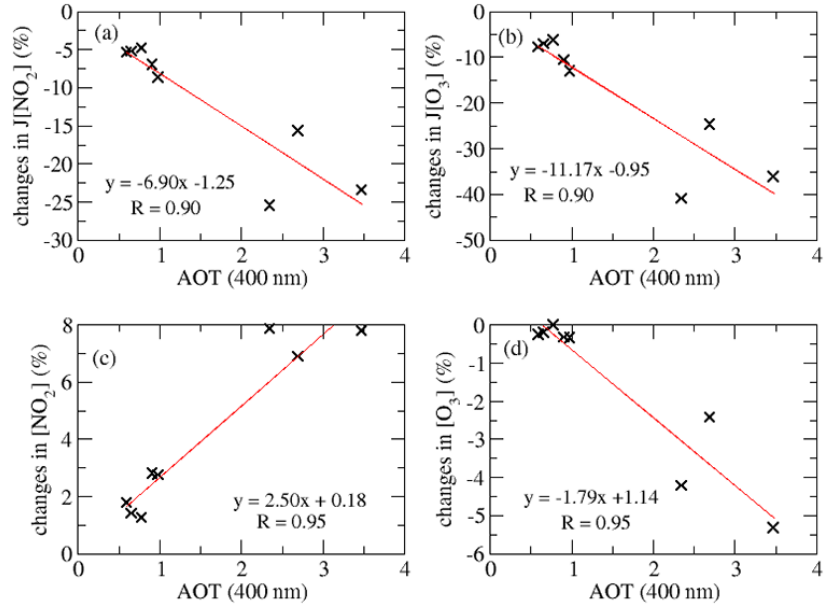
Figure 6. Daytime average percentage changes in the photolysis frequencies and concentrations of nitrogen dioxide and ozone over Moscow as a function of modeled AOT